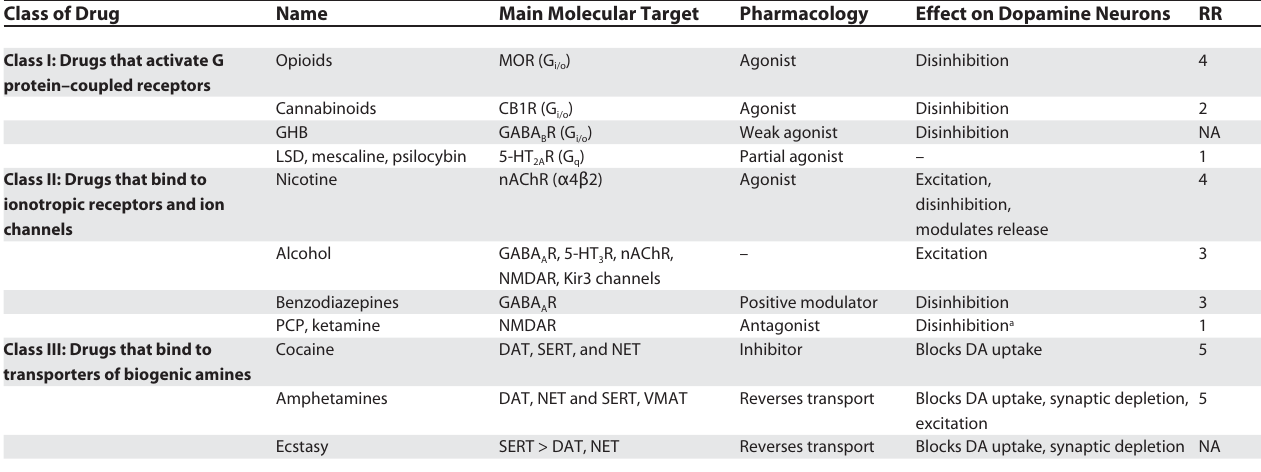
Table 1. The Mechanistic Classifi cation of Drugs of